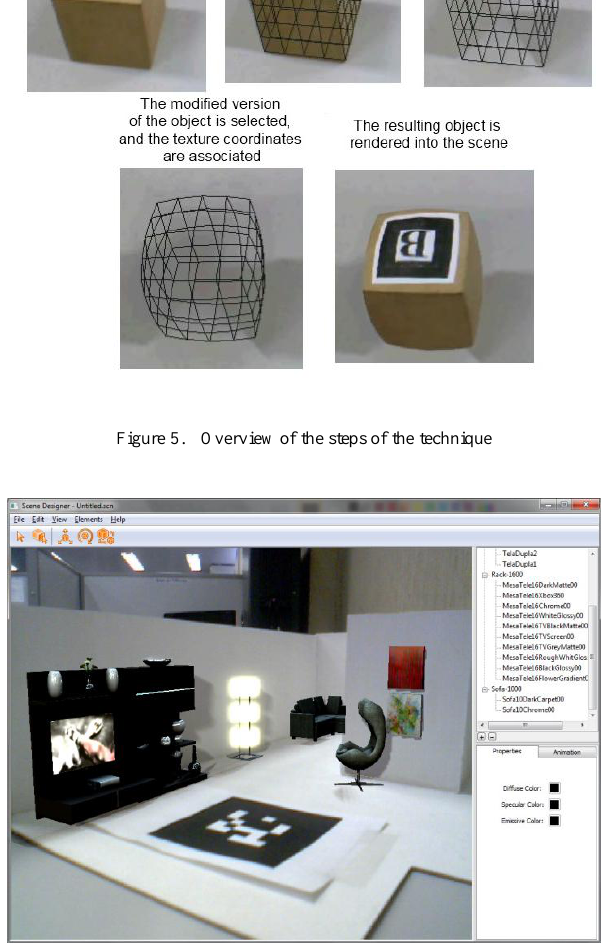
Figure 6. Example of a created scene made with the SceneDesigner